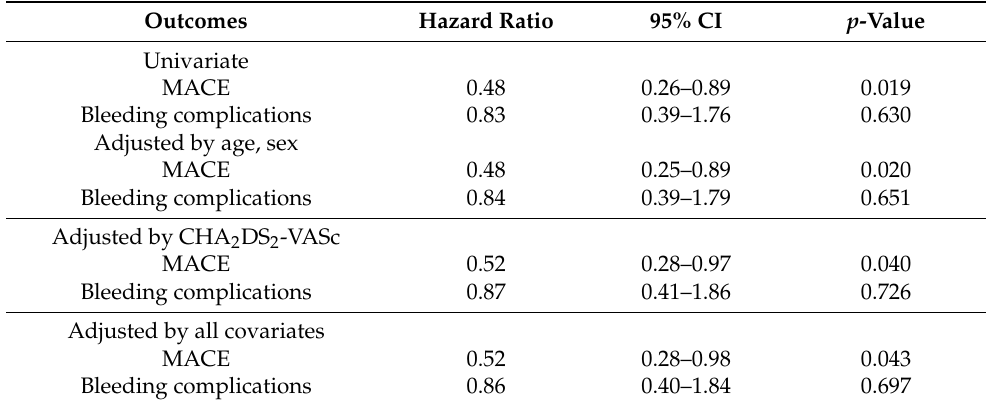
Table 3. Comparison of univariate and multivariate predictors of MACE and bleeding complications between OAC with SAPT and OAC monotherapy.